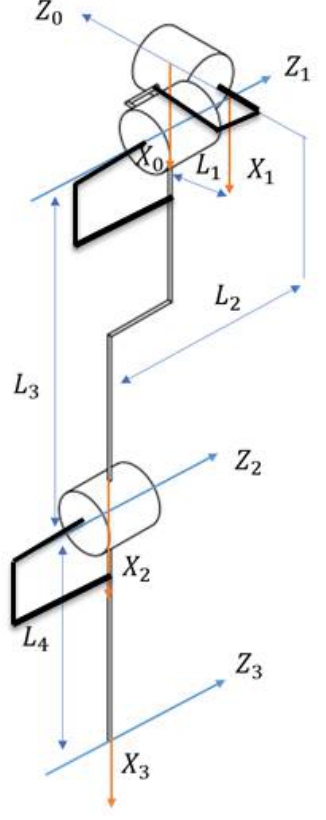
Figure 5. Kinematic structure of SAMA exoskeleton. Where θ i is the joint angle, d i is the joint distance, a i is the link length, and α i is the link twist angle. Additionally, the general transformation matrices defining frame R i relative to Table 2. DH parameters table for SAMA exoskeleton joints. frame R i − 1 are given Link